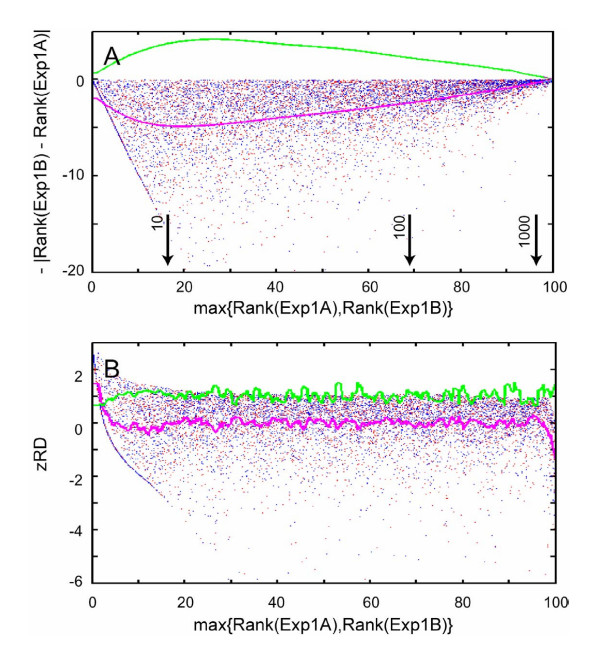
Effect of negative variation normalization. A – Decreasing rank differences in the comparison Wt-t0b vs Wt-t0a are plotted (in blue) against the rank of Wt-t0a and decreasing rank differences in the comparison Wt-t0a vs Wt-t0b are plotted (in red) against the rank of Wt-t0b. A sliding window of 100 points was moved by steps of 30 points. At each position, the mean (lower magenta curve) and std (upper green curve) were plotted and the resulting jagged lines were smoothed by a fitting procedure [25]. The vertical arrows indicate the position of 10, 100 and 1000 signal on the 0–100 rank scale. B – Distribution of zRD (mean (magenta curve) and std (green curve) are not smoothed).